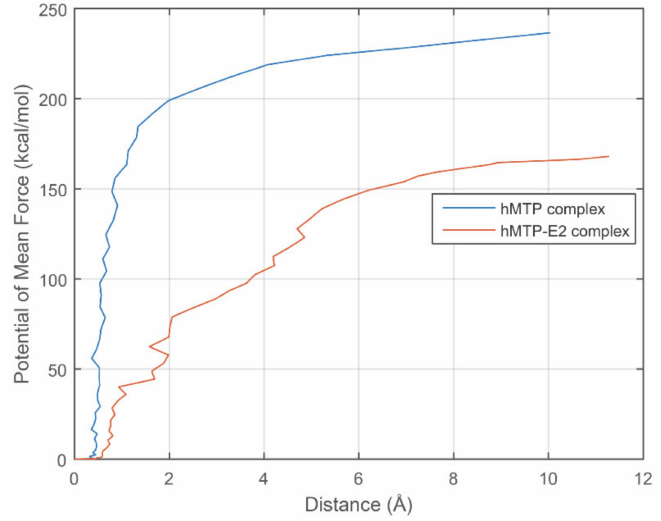
Figure 7. Potential of mean force (PMF) derived from the steered molecular dynamics (SMD) simulation process of the first 1 ns. PMFs of hMTP and hMTP–E 2 complexes calculated from the SMD simulations which start from the conformation after the MD simulations without the hydrogen bond